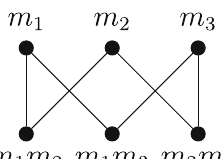
Figure 1: Perfect divisor graph for = n 3 .